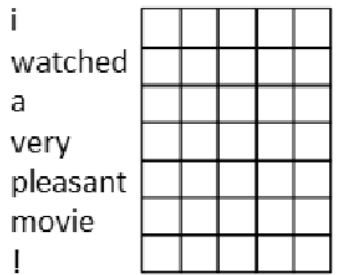
Figure 2. Representation of text by a matrix of real numbers. A word is represented on the horizontal axis by word embeddings, while vertically several words are